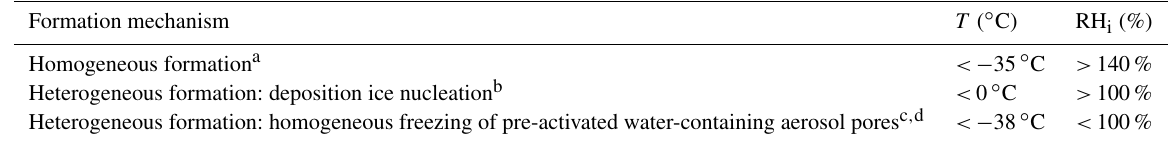
Table 1. Conditions under which diamond dust can form over the Arctic. Heterogeneous ice formation also requires the presence of ice nuclei. Formation mechanism T ( ◦ C) RH i (%) Homogeneous formation a < − 35 ◦ C > 140% Heterogeneous formation: deposition ice nucleation b < 0 ◦ C > 100% Heterogeneous formation: homogeneous freezing of pre-activated water-containing aerosol pores c ,